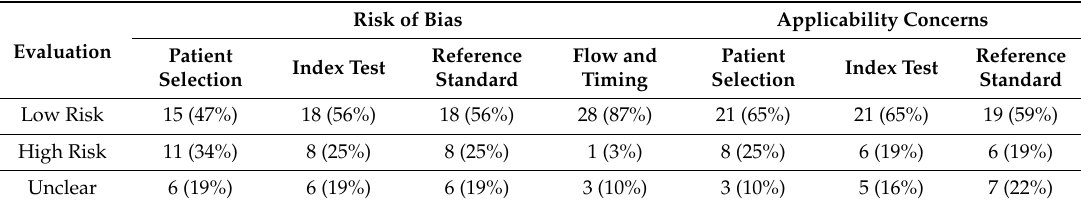
Table 2. QUADAS-2 evaluation of